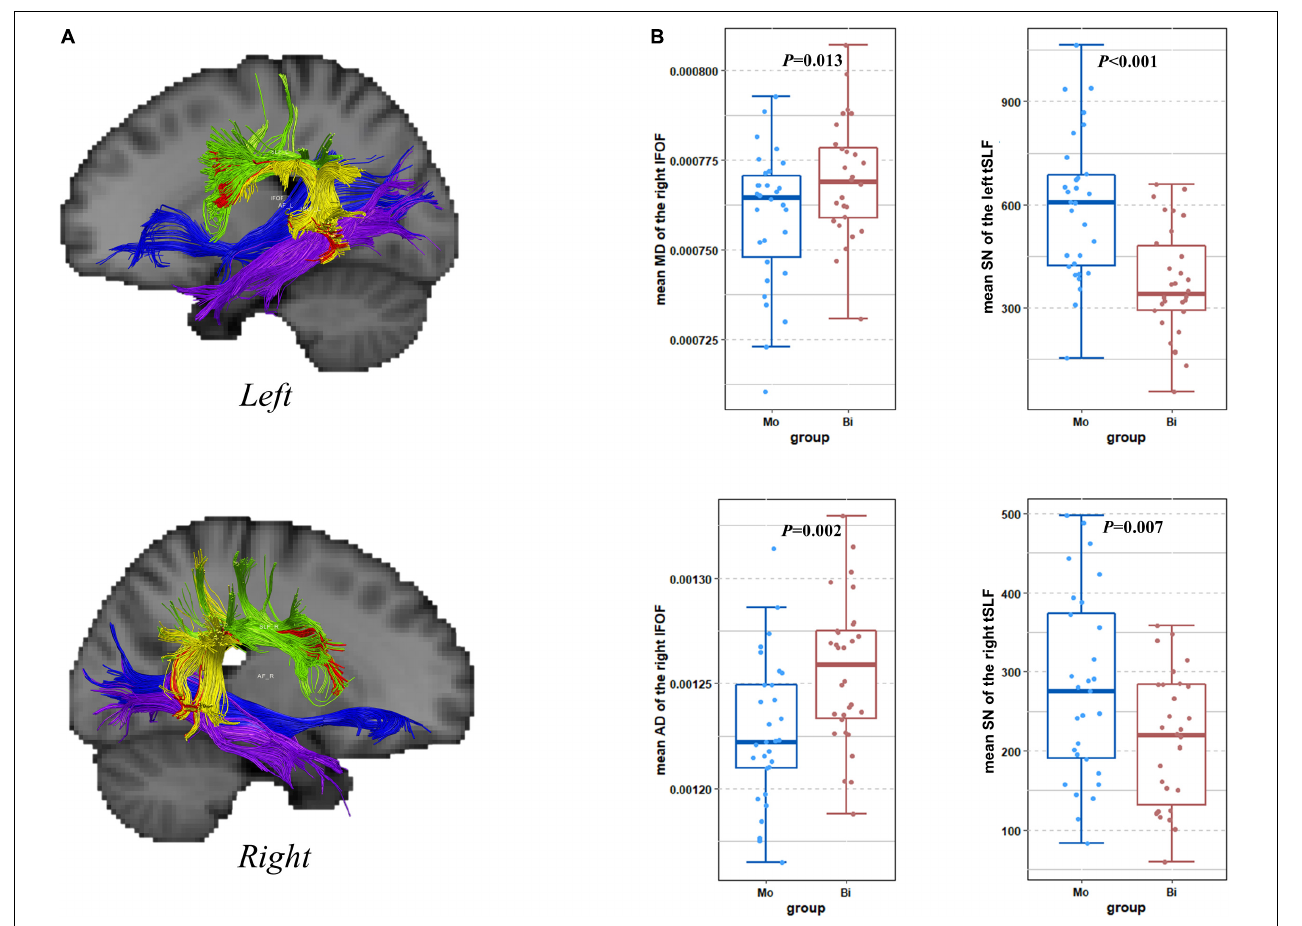
FIGURE 1 | Results of tractography. (A) The five TOIs: fSLF (green), AF (red), tSLF (yellow), ILF (purple), and IFOF (blue) overlaid on a standard MNI brain. (B) The boxplots showing group-wise differences in mean MD, AD, and number of streamlines from tracts. Mo, Monolingual group; Bi, Bilingual group; SN, number of